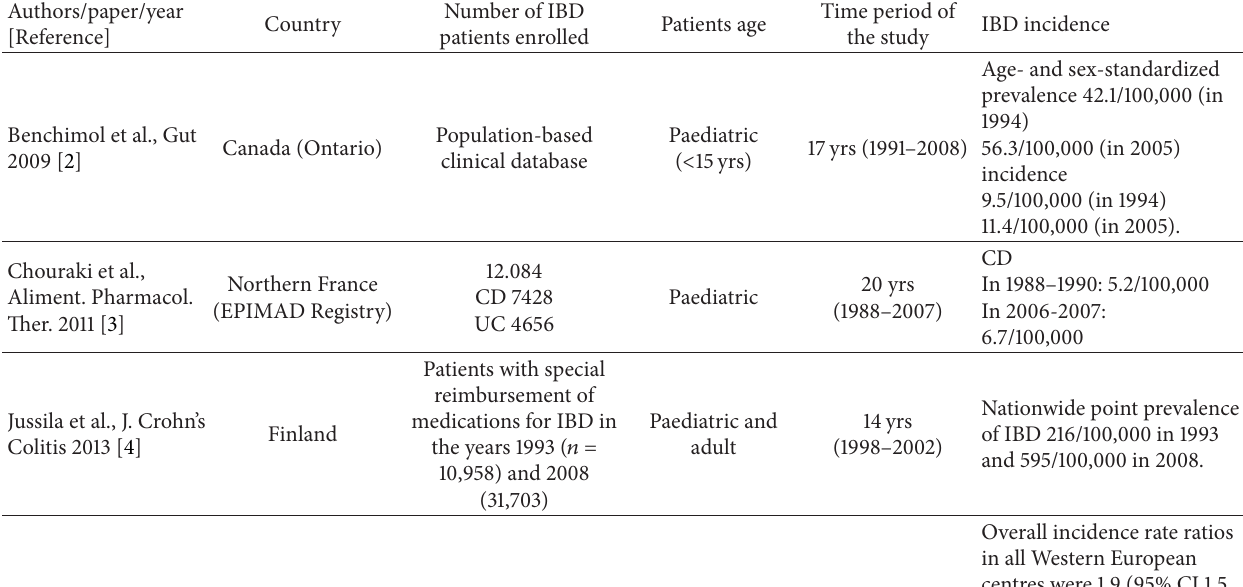
Table 1: Summary of the main studies on IBD epidemiology that were reviewed for the special